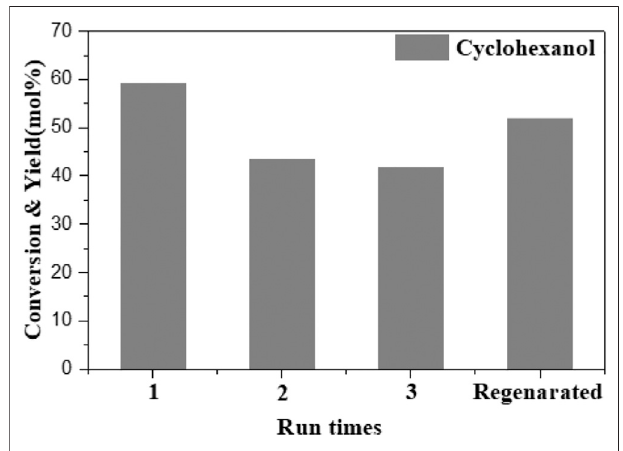
FIGURE 9 | The reusability test of the 10Ni-10Mn/Nb 2 O 5